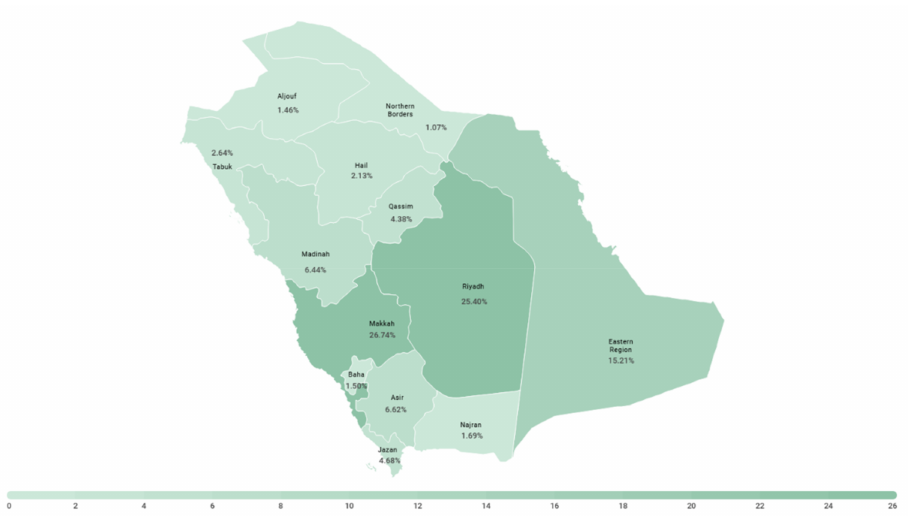
Figure 1. Map of the Kingdom of Saudi Arabia showing the distribution of the adult